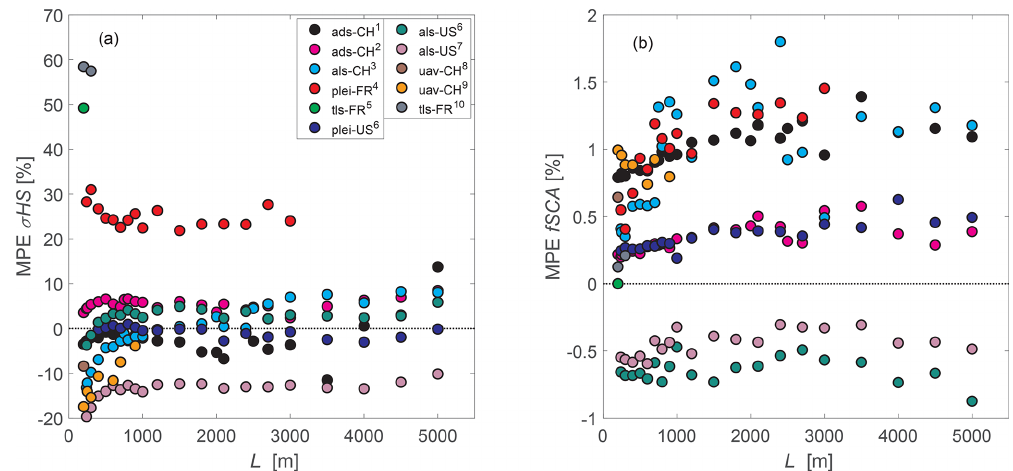
Figure 11. Mean percentage error (MPE) as a function of L for the compiled data set for (a) σ HS and (b) fSCA using Eqs. (1) to (3) with scale-dependent c(L),d(L) . Colors represent the different geographic regions, measurement platforms or acquisition dates (number) of the compiled data set as indicated in Sect. 2.1 to 2.4.